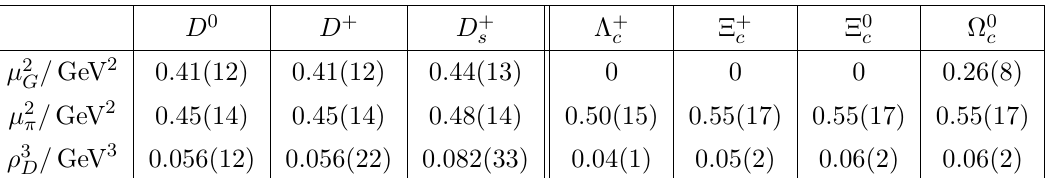
Table 7. Non-perturbative parameters in the non-spectator contributions used in our analysis, including assigned ∼ 30% uncertainties to all the entries, by applying the methods discussed in sections 3.1, 3.2 and 3.3. The values for µ 2 for the Ξ baryons are derived by replacing m π with m , and similarly for the Ξ 0 , which has the effect of lifting the values slightly and accounts for c Ξ + c SU(3) -breaking. The central values of the Darwin parameters for the mesons are adopted from [39]. F We estimate the central values of the Darwin parameters for the baryons using the equation of motion for the gluon field with α = 1 , see section 5, and our constituent quark model estimates of s the dimension-six four-quark matrix elements in eqs. (5.17) and (5.18)).